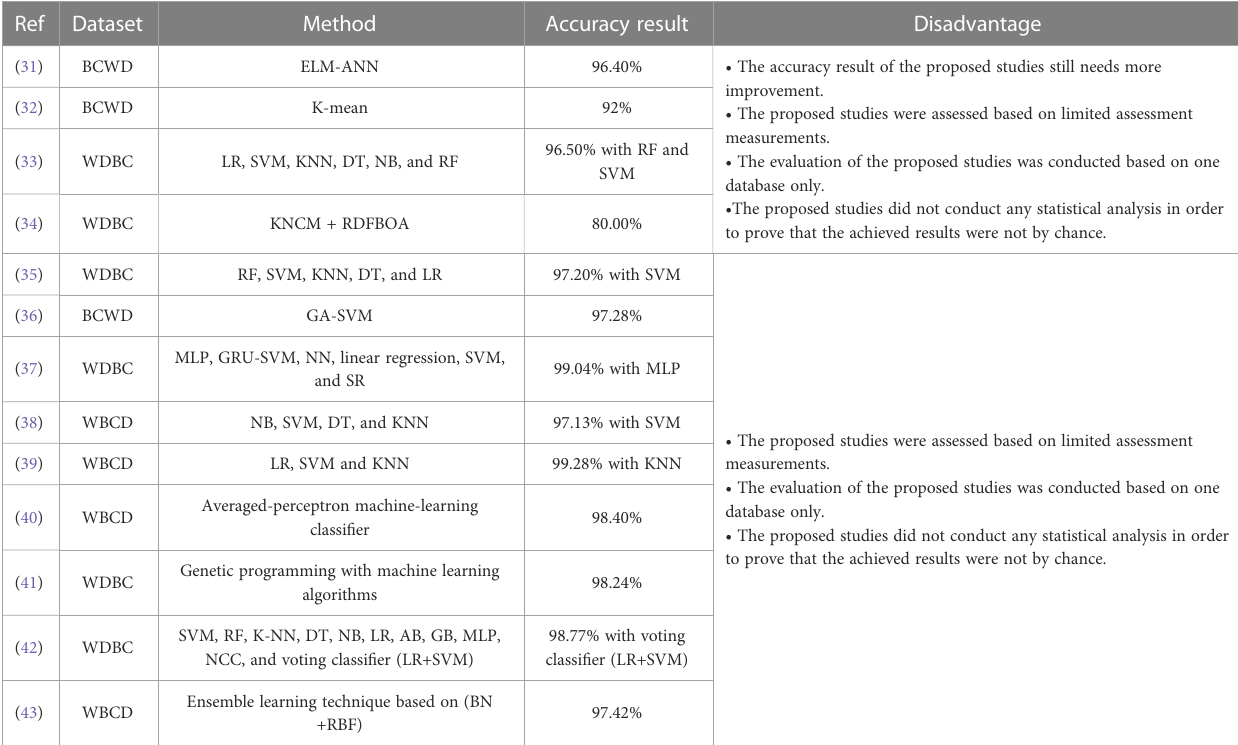
TABLE 1 Summary of the previous